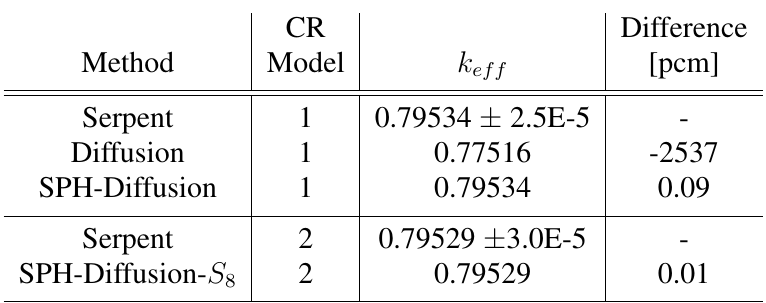
Table 3: Eigenvalue results for the TREAT control rod problem